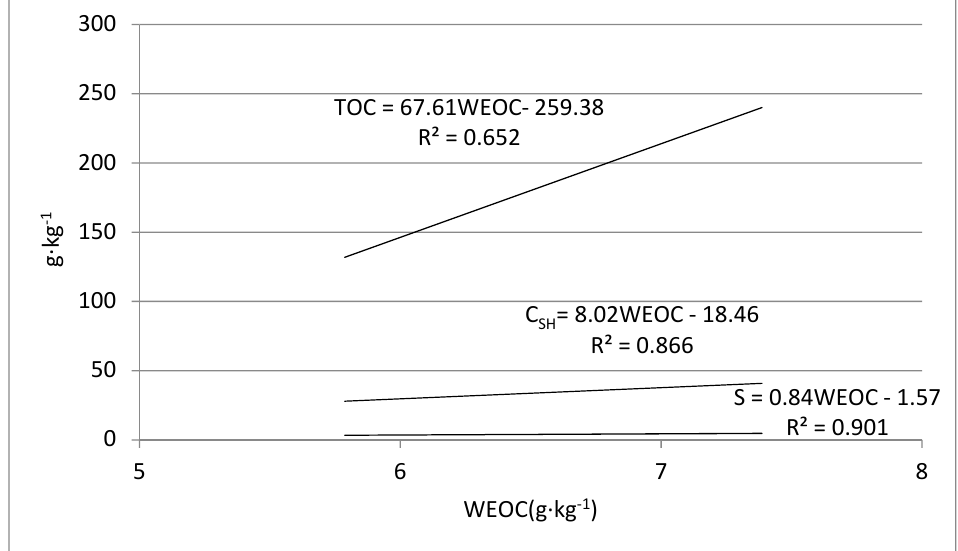
Figure 7. Linear regression for water extractable organic carbon (WEOC) and humic substance (C SH ), total organic carbon (TOC) and S in vermicomposts.